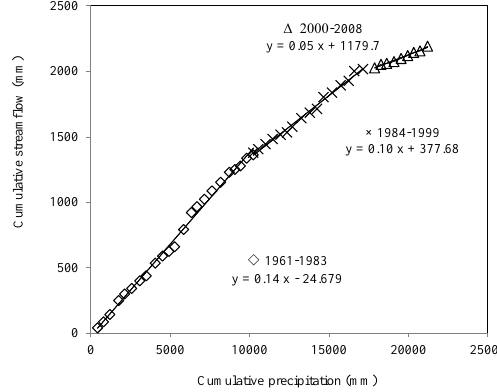
Figure 6. The double-mass curve showing the relations between cumulative streamflow and cumulative precipitation for the Miyun Reservoir catchment (1961–2008).